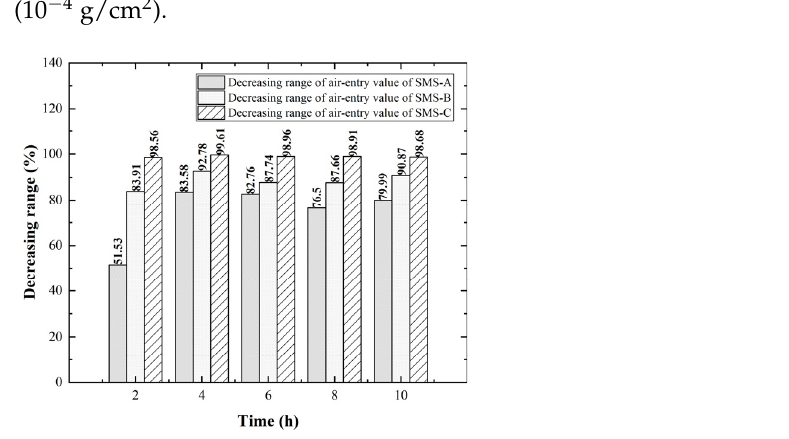
Figure 11. Decreases in air-entry values of soil with different hydrophobic treatments.